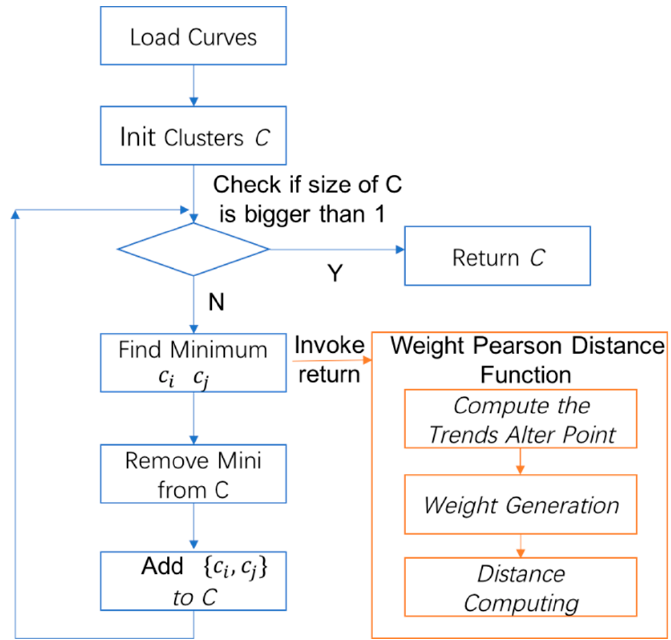
Figure 2. The overall flowchart of the weighted Pearson-based hierarchy clustering algorithm. Algorithm 2. The Weight Pearson based Hierarchy Clustering Algorithm.